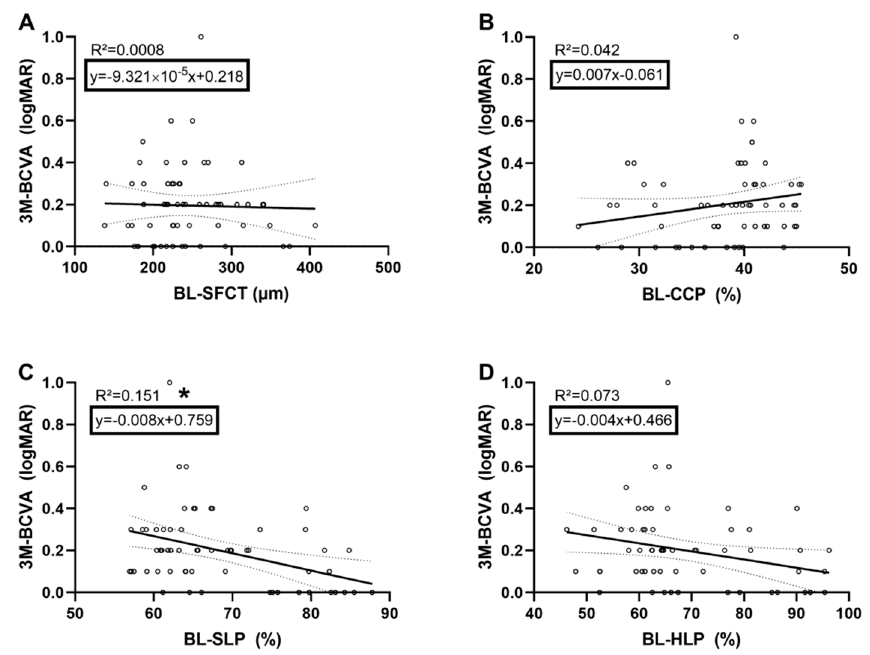
Figure 3. Linear regression model showing the 3-months (3M) BCVA dependency of each SFCT ( A ), CCP ( B ), SLP ( C ), and HLP ( D ) at baseline (BL). Black line represents the linear regression line; dotted line shows the upper and lower bound of the 95% confidence interval. * signifies p <